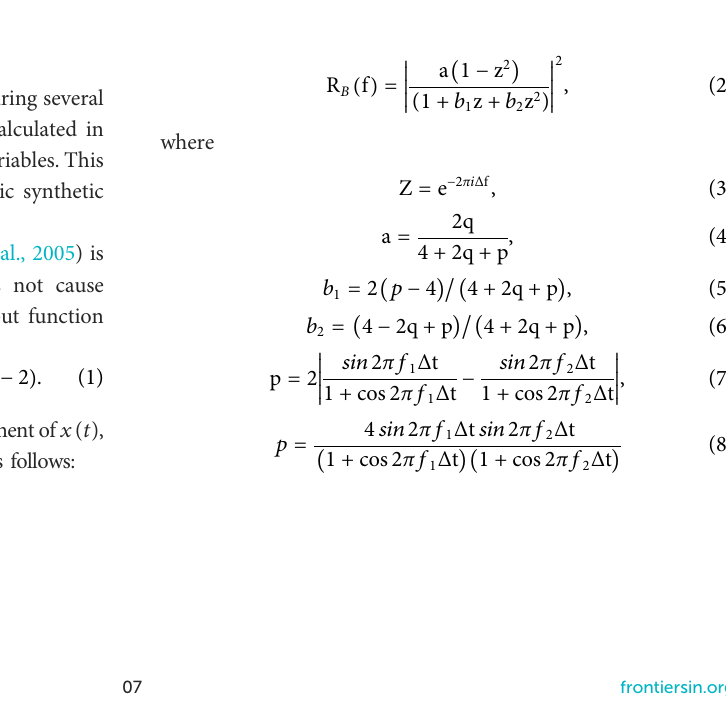
Frontiers in Earth